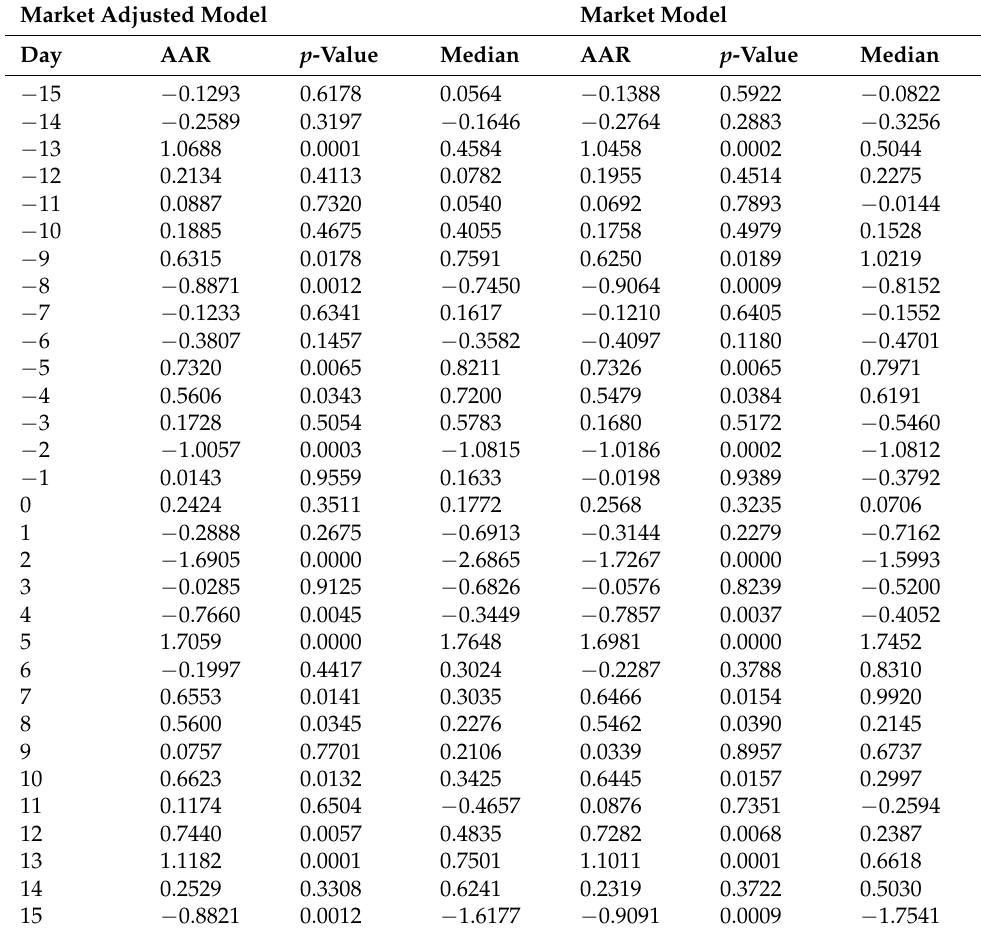
Table 2. AAR from the market adjusted model and the market